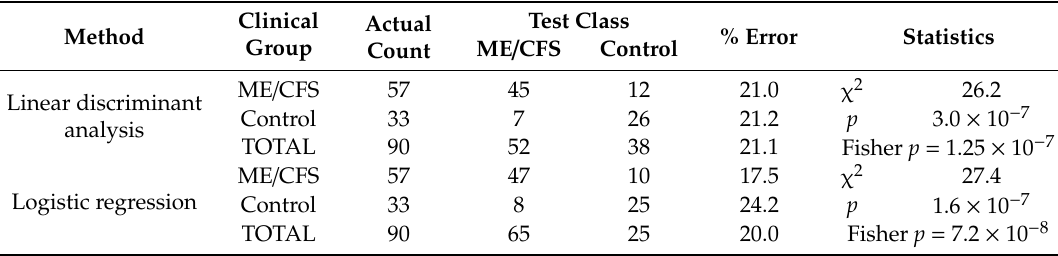
Table A1. Confusion matrix for linear discriminant analysis of PBMC death rate after 24, 48 and 72 h in culture